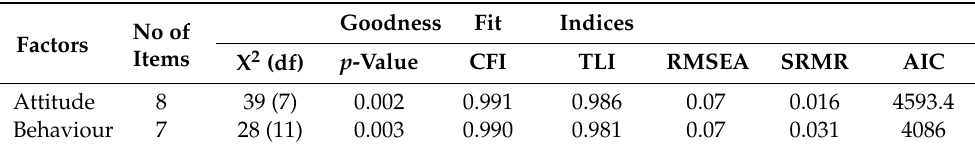
Table 7. Fit indices for confirmatory factor